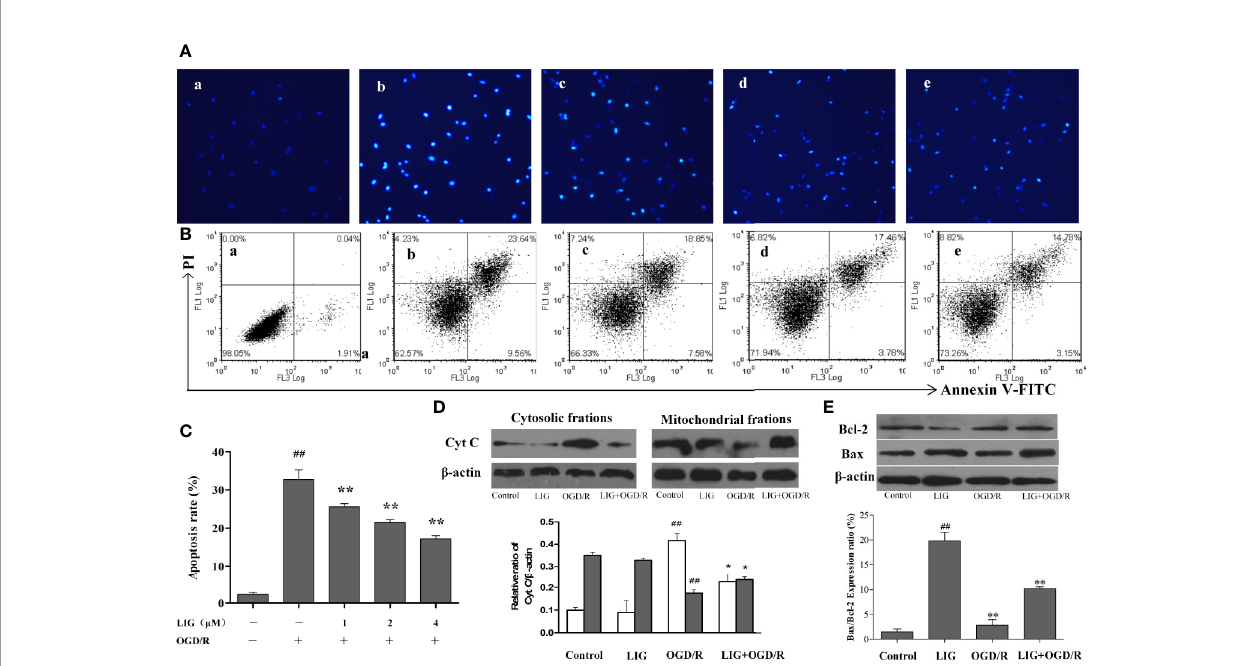
FIGURE 3 | The effect of ligustilide on oxygen-glucose deprivation/reperfusion (OGD/R)-induced apoptosis of hippocampal neurons. (A) The percentage of hippocampal neurons apoptosis was analyzed by staining cells with Hoechst 8 (blue represents viable cells, ×200). (B, C) Apoptotic cells rate were detected by fl ow cytometry. (a) Control group; (b) OGD/R; (c) 1 m M LIG+OGD/R; (d) 2 m M LIG+OGD/R; (e) 4 m M LIG+OGD/R. (D) Western blot image and the expression analysis of Cyt C in mitochondrial and cytosolic fractions. (E) Western blot image and the expression analysis of Bcl-2 and Bax. Data shown are the results of three different experiments. ## P < 0.01 vs. control group; * P < 0.01, ** P < 0.01 vs. group treated with